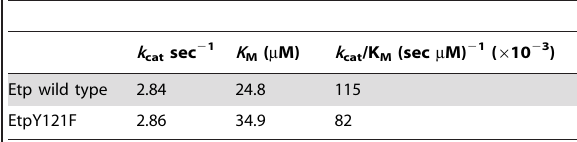
Table 1. In vitro kinetics of MBP-Etk dephosphorylation by 6His-Etp and 6His-EtpY121F.